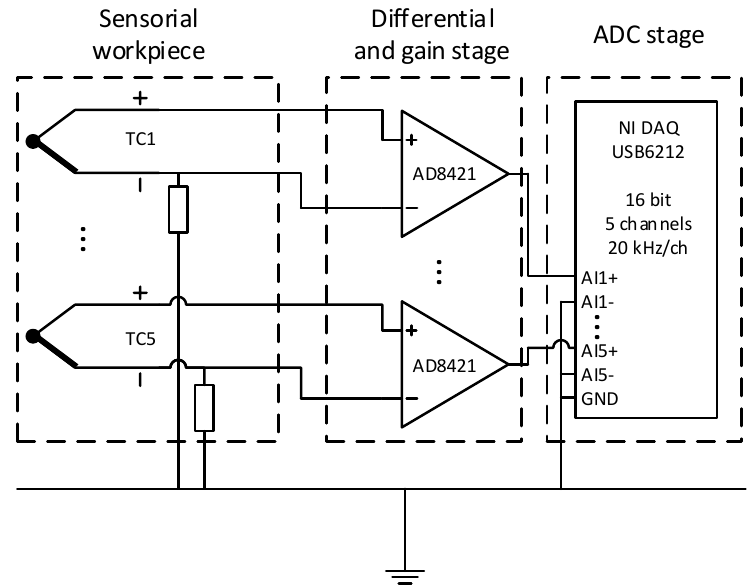
Figure 3. Electronics setup consisting of thermocouples, differential and gain stage, and analog-to- digital conversion stage. digital conversion